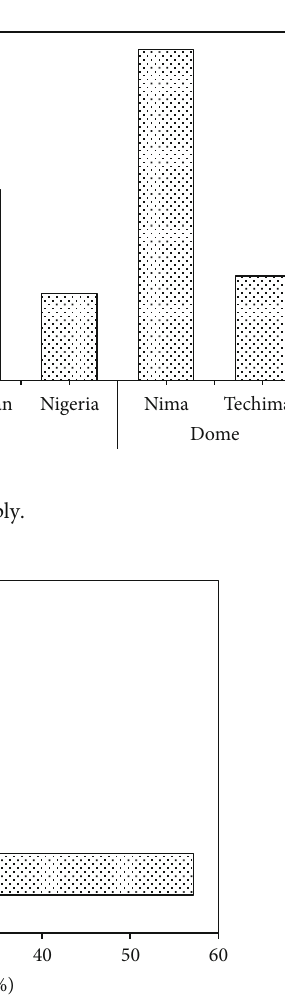
Figure 2: Packaging material for bulk storage of egusi powder by Table 2: Chemical properties of melon seed powder from four Ghanaian markets.